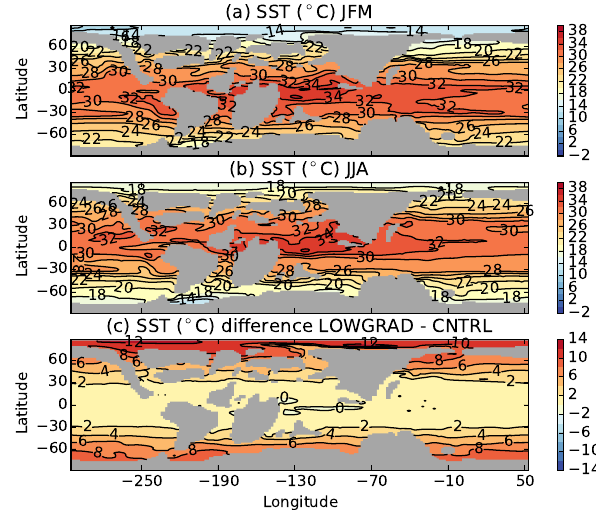
Figure 1. Average sea surface temperature (SST, ◦ C) for the simu- lation with altered radiative balance, LOWGRAD, in (a) January, February, March, (b) June, July, August and (c) SST difference LOWGRAD – CNTRL. Model geography is that of the Turonian period (90–94Ma) of the